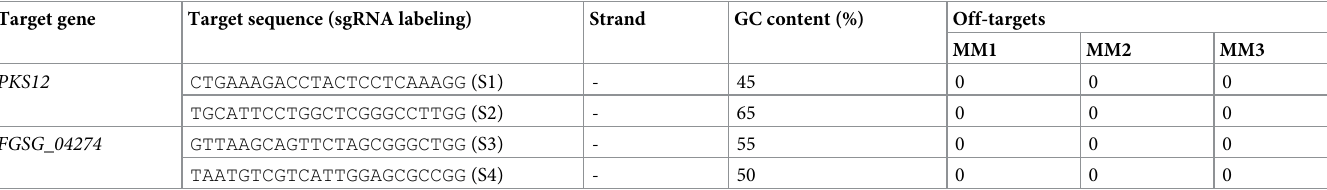
Table 2. The CHOPCHOP [20] results of selected sgRNAs. The number of potential off-targets and GC% of the target sequence are shown. Target